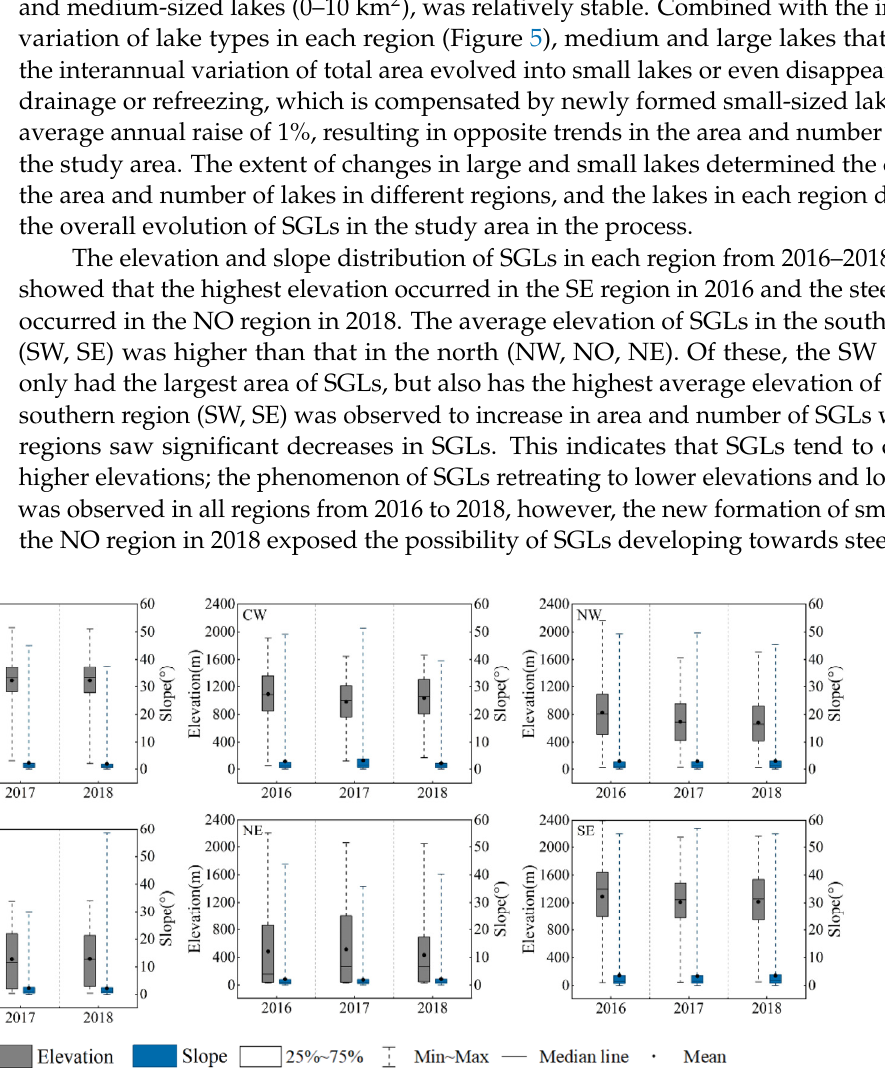
Figure 9. Topographic distribution of regional SGLs from 2016 to